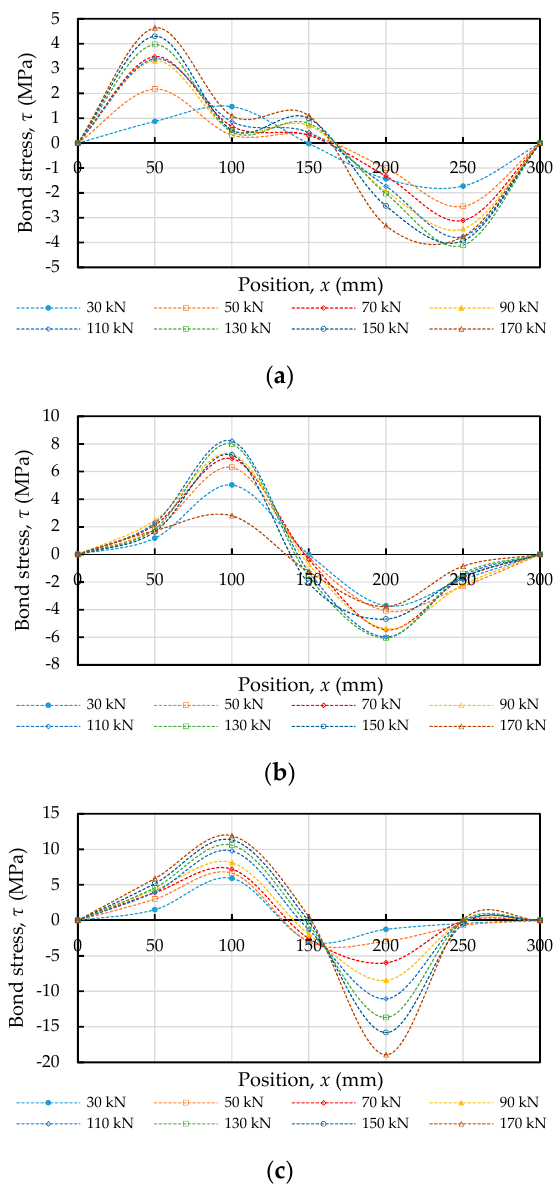
Figure 10. Bond stress distribution along steel bars subjected to tensile load: ( a ) C20, ( b ) C40, and ( c ) C60.